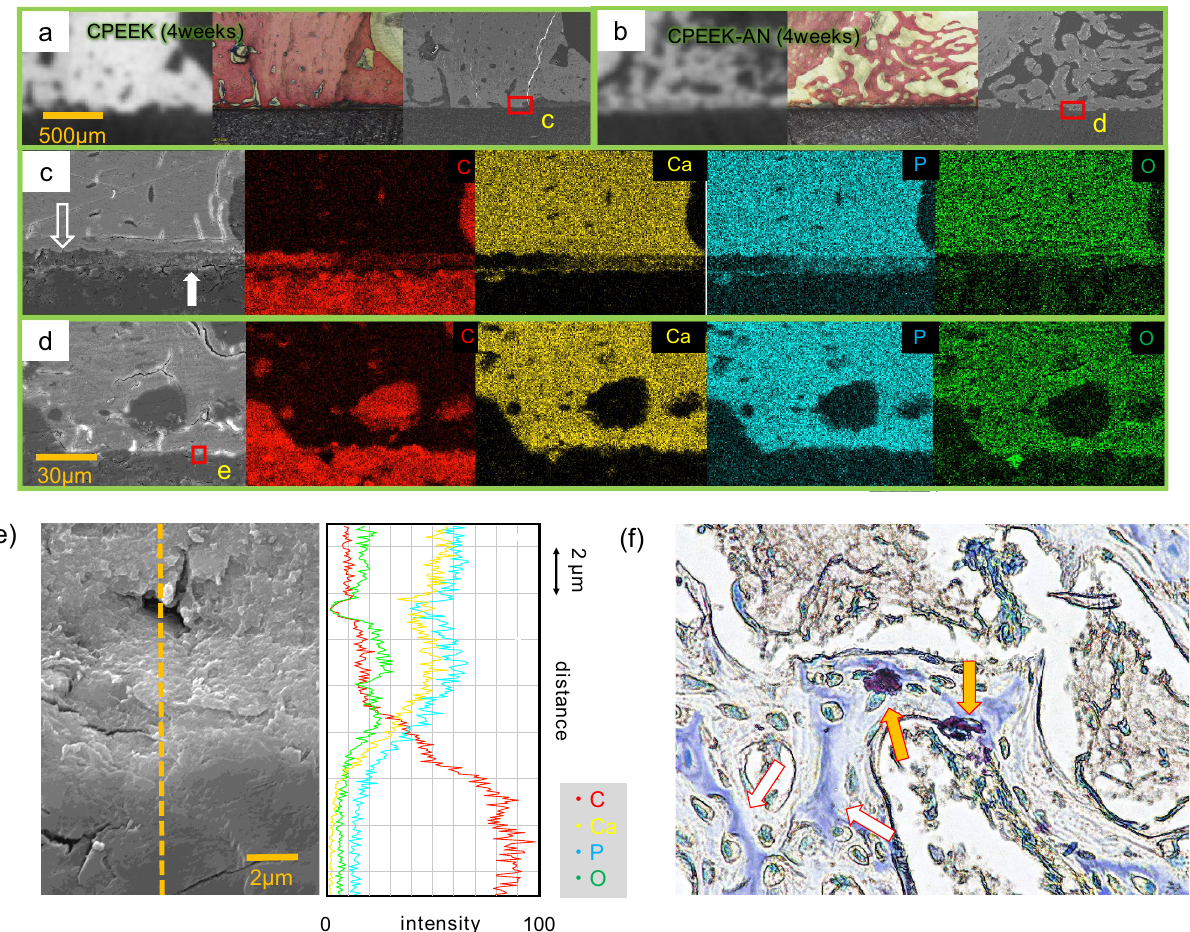
Figure 7. Interfacial evaluation2. Corresponding CT, histological, and SEM images of samples taken from a 4-week-old rabbit ( a ) with CPEEK and ( b ) with CPEEK-AN. ( c ) Magnified image of ( a ) using SEM and matched EDX mapping analysis of the composite. The hollow arrow points to the gap between the implant and the new bone. The solid white arrow indicates the middle progress during ossification. ( d ) Magnified image of ( b ) using SEM and matched EDX mapping analysis of the composite. ( e ) The line analysis for ( e ) which includes the interface between CPEEK and the new bone. ( f ) A section of the histological specimen of CPEEK-AN at 4 weeks co-stained with TRAP and ALP; this image illustrates a typical woven bone. The orange arrows indicate the TRAP positive cells and the hollow arrows indicate an ALP positive part of the new bone at the 4-week